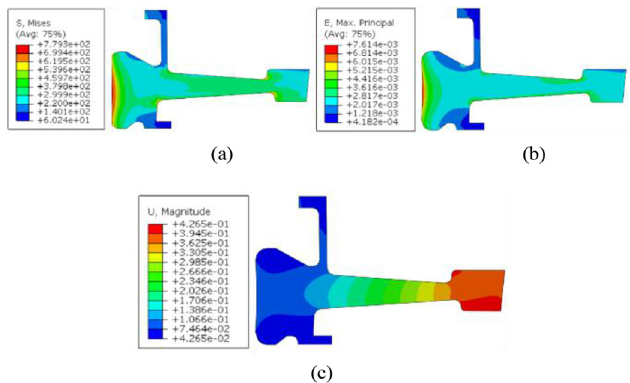
Fig. 8. SimulationresultsofGH4169alloyturbinediscinmaximum state: (a) von Mises stress distribution nephogram, (b) strain distribution nephogram, and (c) deformation distribution nephogram.